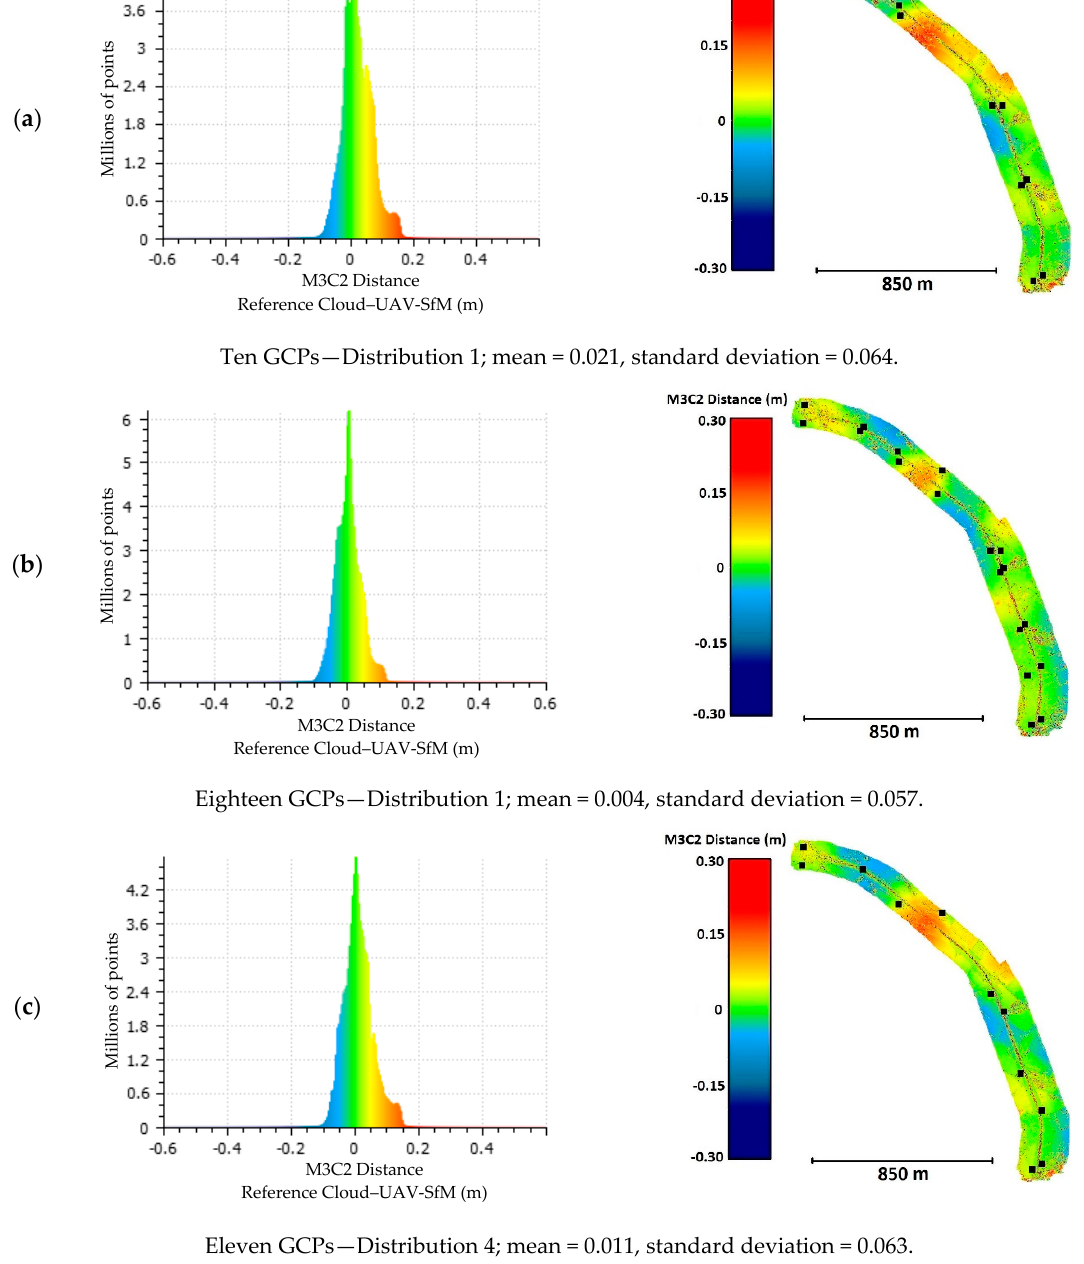
Figure 13. Distribution of errors for the M3C2-calculated distance between the reference cloud and the clouds obtained from the photogrammetric projects that used more than nine GCPs. The black squares represent the locations of the GCPs. ( a ) Project with 10 GCPs in Distribution 1, ( b ) project with 18 GCPs in Distribution 1, and ( c ) project with 11 GCPs in Distribution 4.